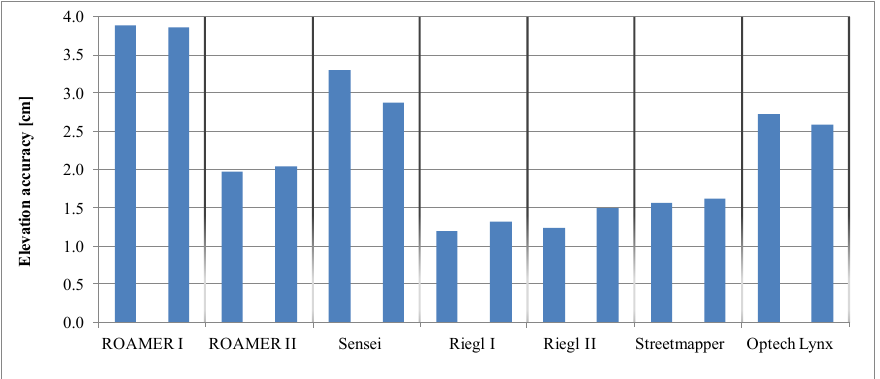
Figure 15. The elevation accuracy values (std), in cm, for the tested MLS systems for the two driving directions. The left column stands for counter-clockwise, CCW, and the column on the right for clockwise, CW,